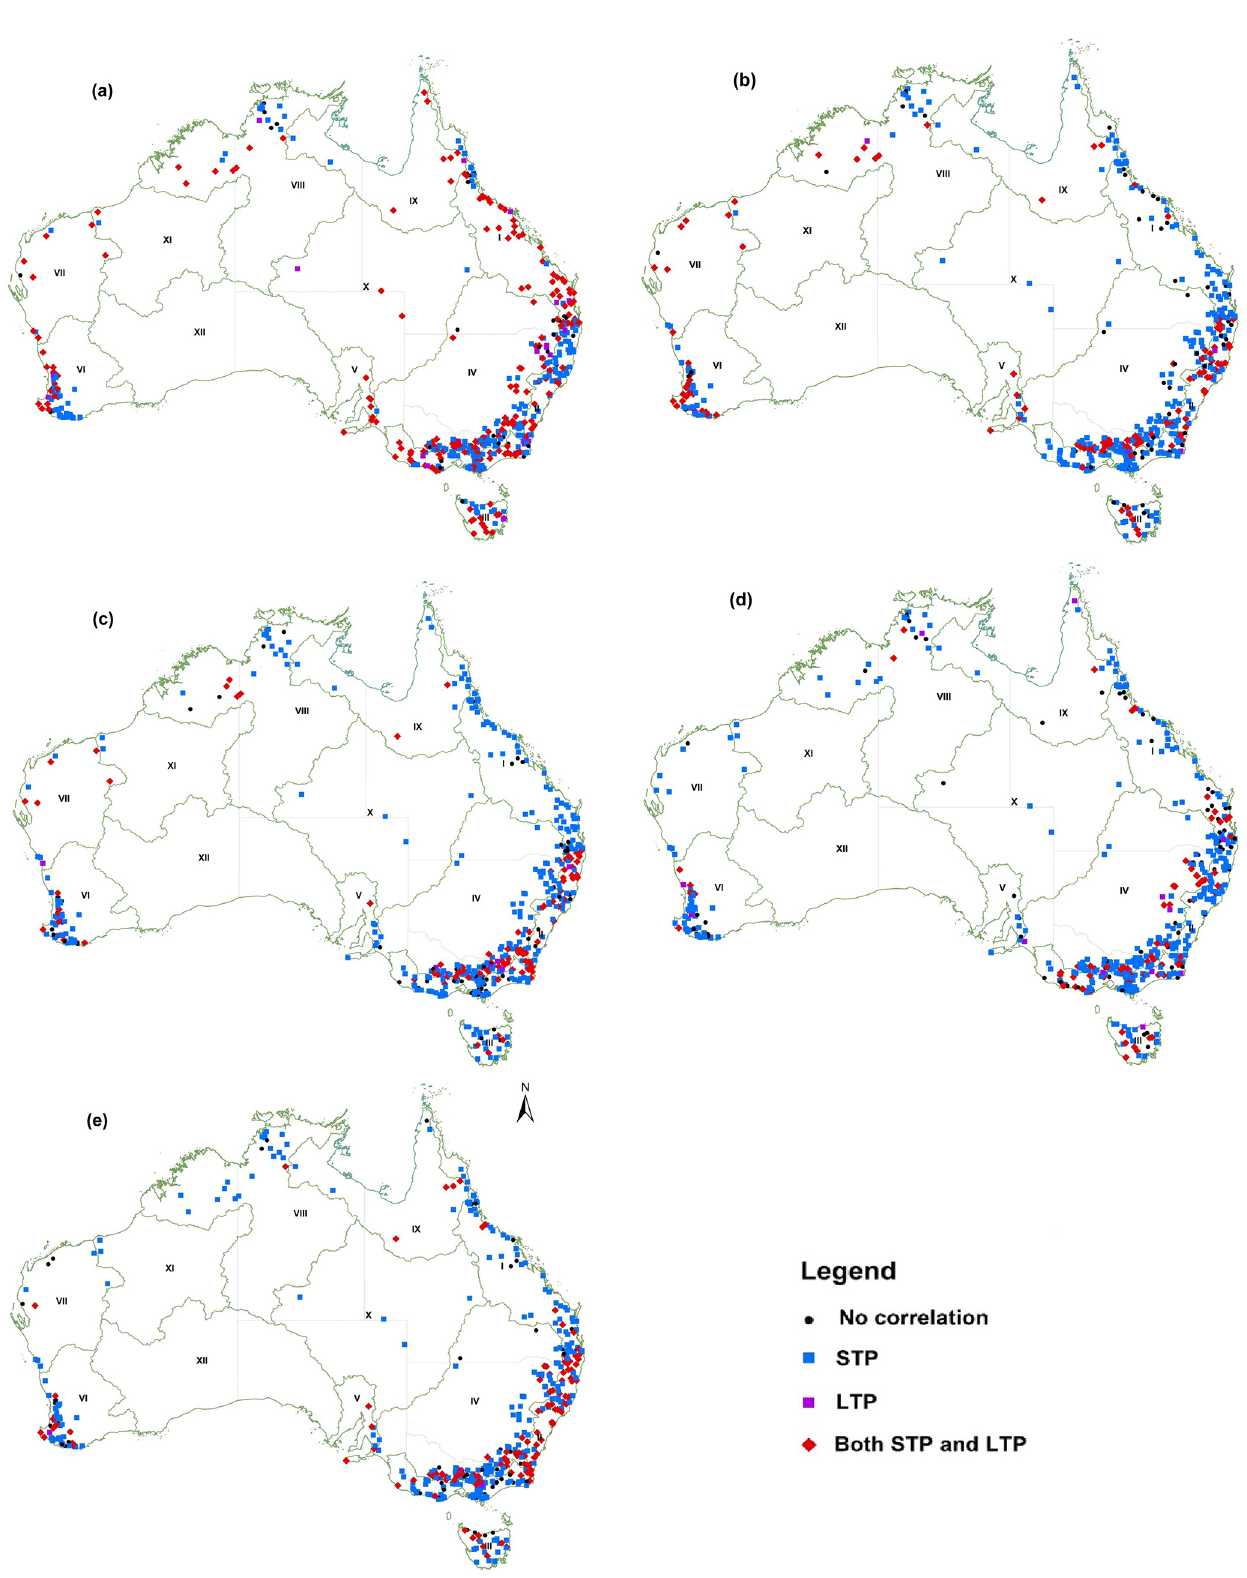
Figure 6. Spatial distribution of stations where streamflow shows persistence, short-term persistence (STP) and long-term persistence (LTP), in (a) autumn (March–May), (b) winter (June–August), (c) spring (September–November), (d) summer (December–February) and (e) annu- ally (water year) at p < 0 .